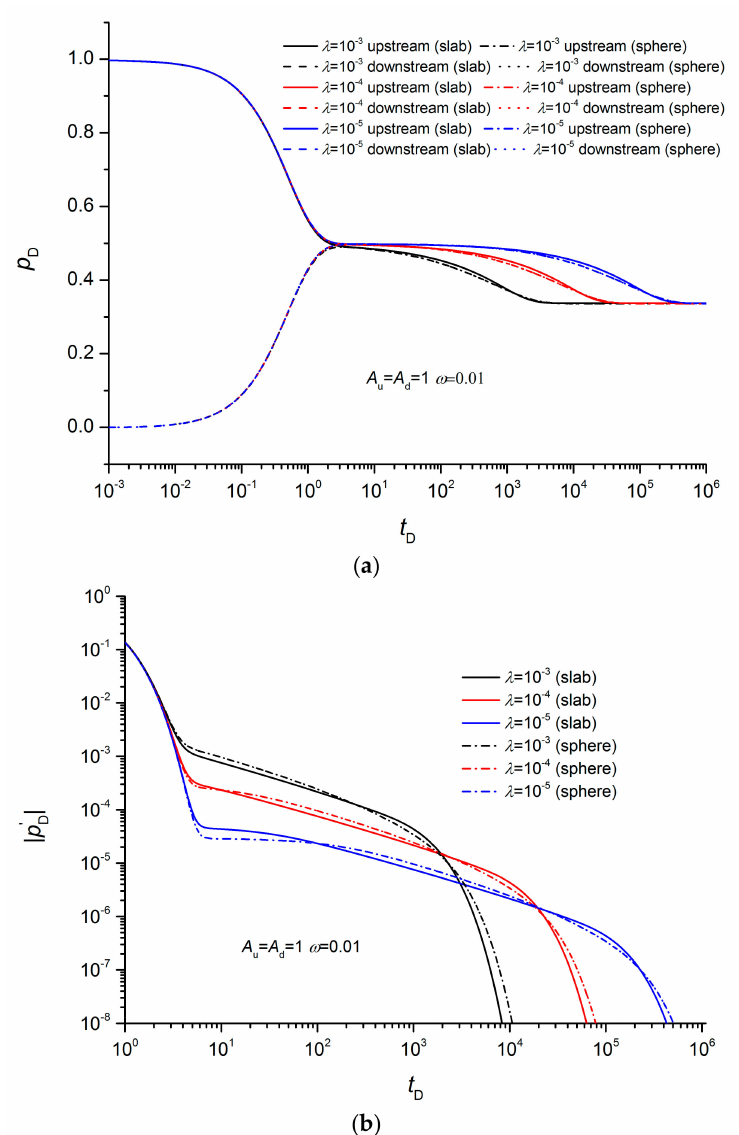
Figure 5. E ff ect of interporosity flow coe ffi cient on pulse decay tests for dual-porosity cores. ( a ) Pressure history. ( b ) Pressure derivative